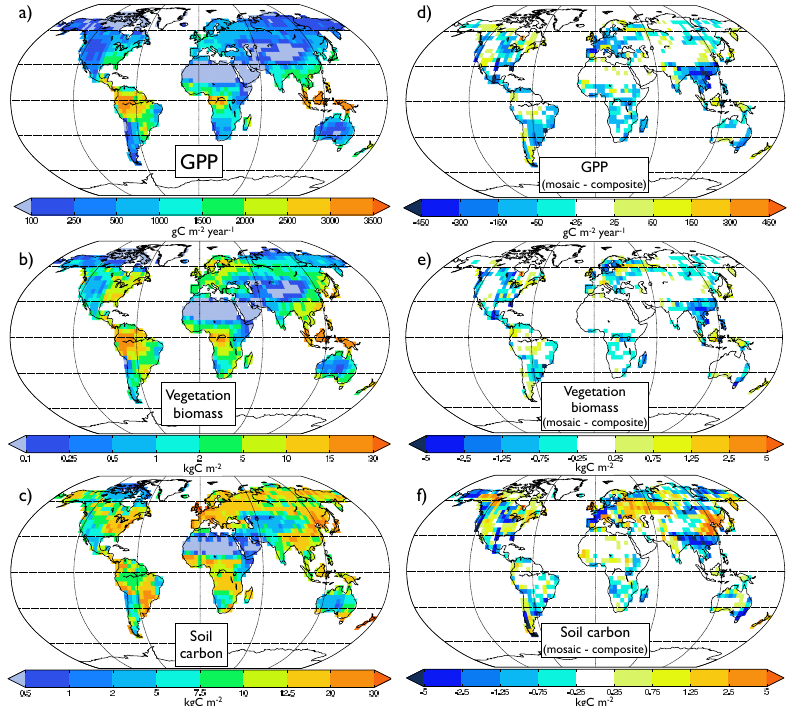
Fig. 3. Pre-industrial equilibrium CLASS-CTEM results using the mosaic approach for (a) GPP, (b) vegetation biomass, and (c) soil carbon mass. The difference between the mosaic and composite approach is shown in the right-hand column for (d) GPP, (e) vegetation biomass, and (f) soil carbon mass. Positive values indicate that the values from the mosaic approach are larger; negative values indicate that the composite approach yields larger values. Table 2. Results from the pre-industrial equilibrium simulations using the composite and mosaic model configurations. Values are a 40yr average at the end of model spin-up. The spin-up cycled over climate years 1901–1940 with year 1861 atmospheric (CO 2 ) and land